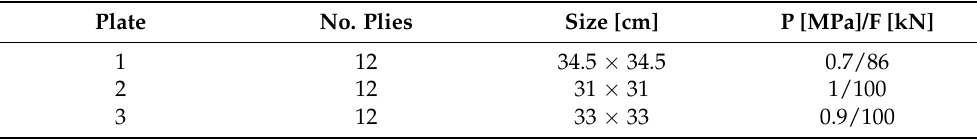
Table 1. Processing parameters for the three manufactured plates, presented in rounded numbers.